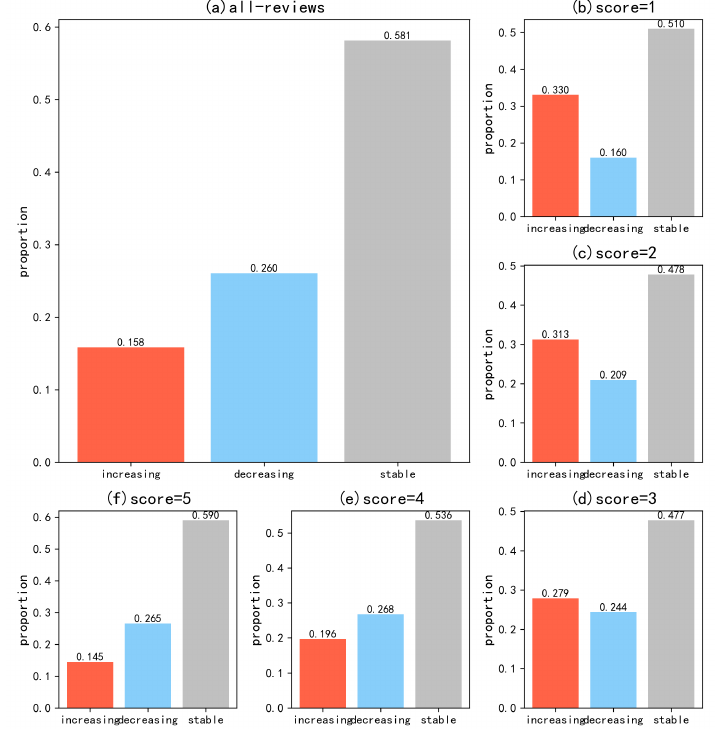
Figure A11. Proportion of emotion shifts in all reviews and all reviews with different scores, taking the Computer sector as an example. The x -axis shows the three types of emotion shifts defined above. The heights of different-colored bars refer to the percentage of a certain kind of emotion shift in all after-use comments. Note that the results from other sectors are the same.